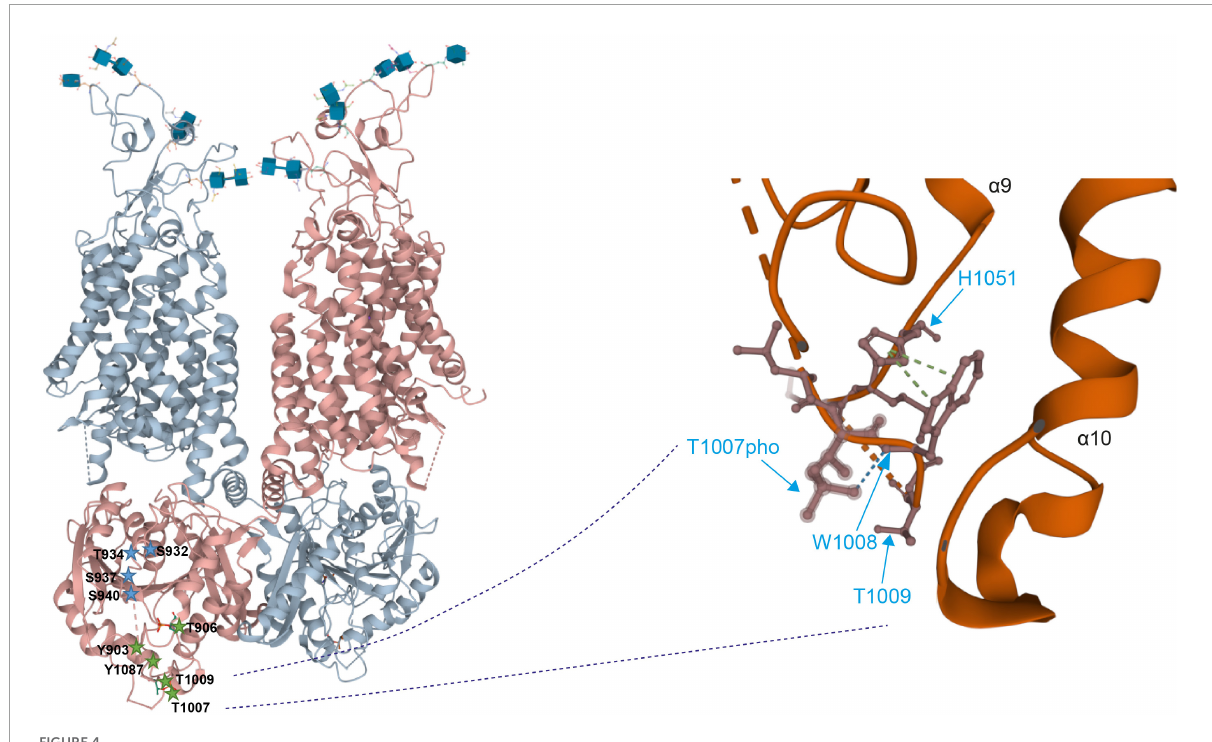
FIGURE4 Detailed view on the 3D structure of the KCC2 C-terminus (Left). Overall 3-dimensional organization of human KCC2 (Right). Detailed view of the localization of phosphorylated Thr 1007 and Thr 1009 . Dashed lines indicate missing density and thus lack of structural information. The 3D reconstruction of KCC2 was generated using cryo-EM (Chi X. et al., 2020). 3D visualization was performed using Mol* Viewer in PDB (Sehnal et al.,